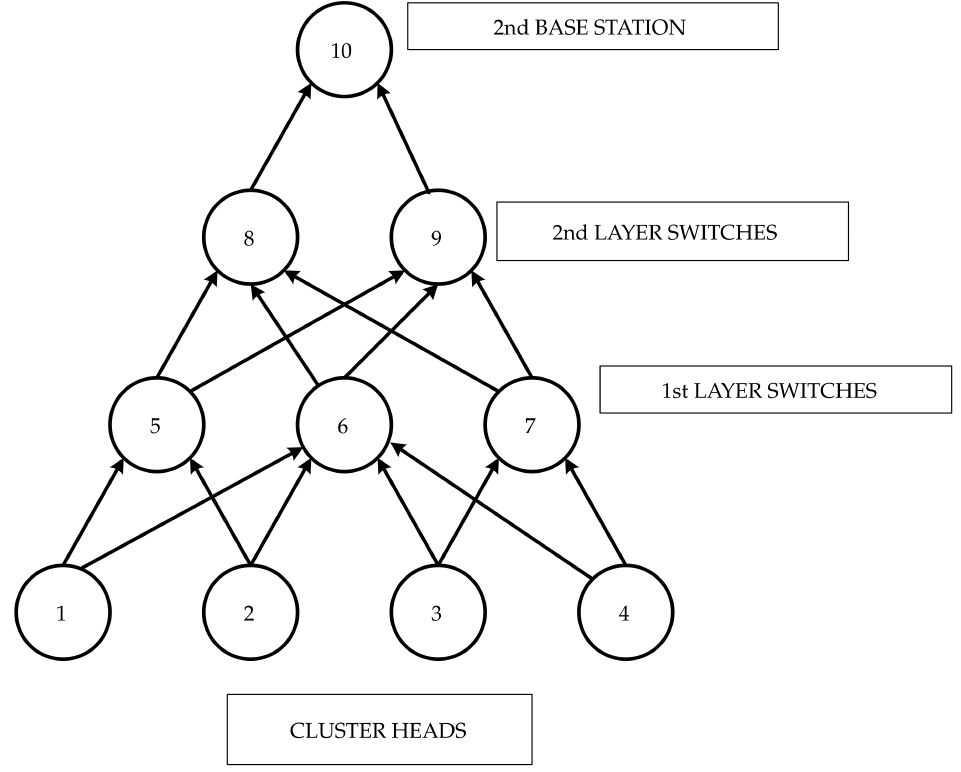
Figure 5. Networking Topology connecting cluster heads and redundant base